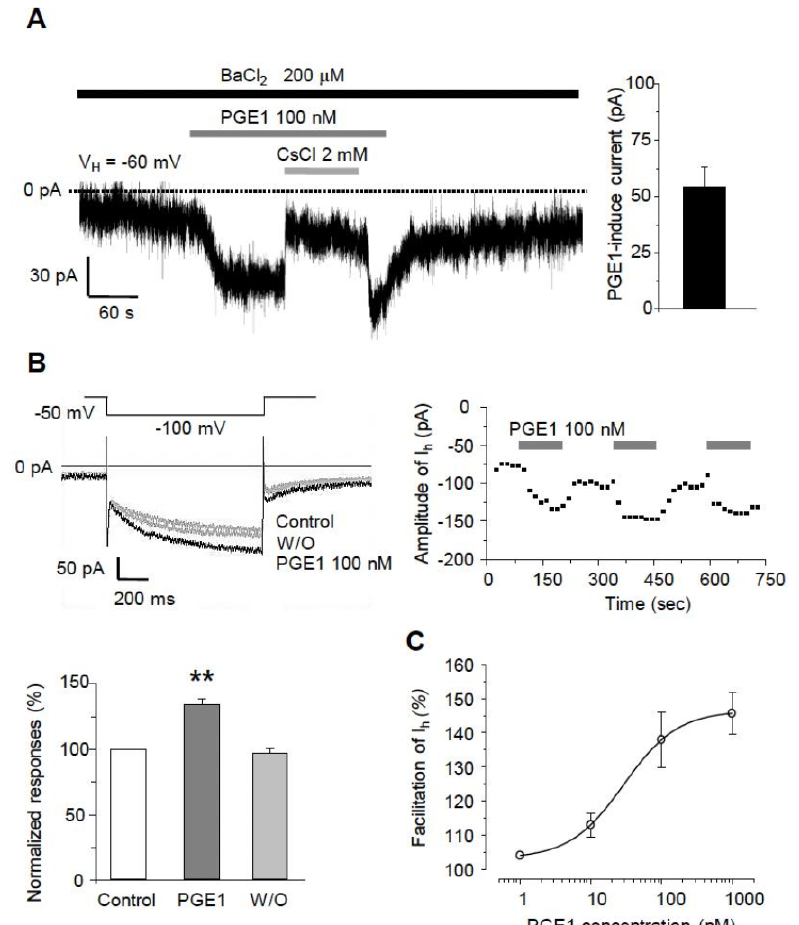
Figure 2. The facilitatory effects of PGE1 on I h in TG neurons. ( A ) Left: Inward currents were activated by PGE1 (100 nM) in the presence of BaCl 2 at the holding potential of − 60 mV in TG neurons. The PGE1-induced inward current was blocked by CsCl (2 mM). Right: Summary of the amplitude of PGE1-induced inward current. ( B ) Recordings of I h were measured during 1 s hyperpolarizing test potential of − 110 mV from a holding potential − 50 mV with 20 s interval. The traces of I h were superimposed before and after the application of PGE1 (n = 9). The facilitation of I h currents by PGE1 was repetitive. Summary of I h facilitation by PGE1 relative to the control. Results are presented as the mean ± SEM (** p < 0.001, paired t-test). ( C ) The concentration-response relationship of facilitation by PGE1. The dose-response curve for PGE1 action on I h in TG neurons. The facilitatory effect of PGE1 (1, 10, 100, and 1000 nM) on I h was in a dose-dependent manner in TG neurons and the median effective dose (ED 50 ) of PGE1 was 29.3 nM for I h current. Results are presented as the mean ±